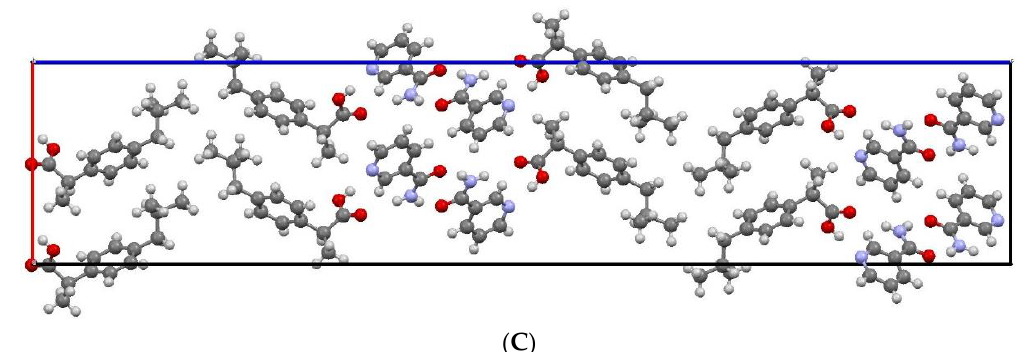
Figure 1. Chemical structures of ( A ) ibuprofen (IBF) and ( B ) nicotinamide (NA). ( C ) Packing structure of an IBF/NA cocrystal (SODDIZ).